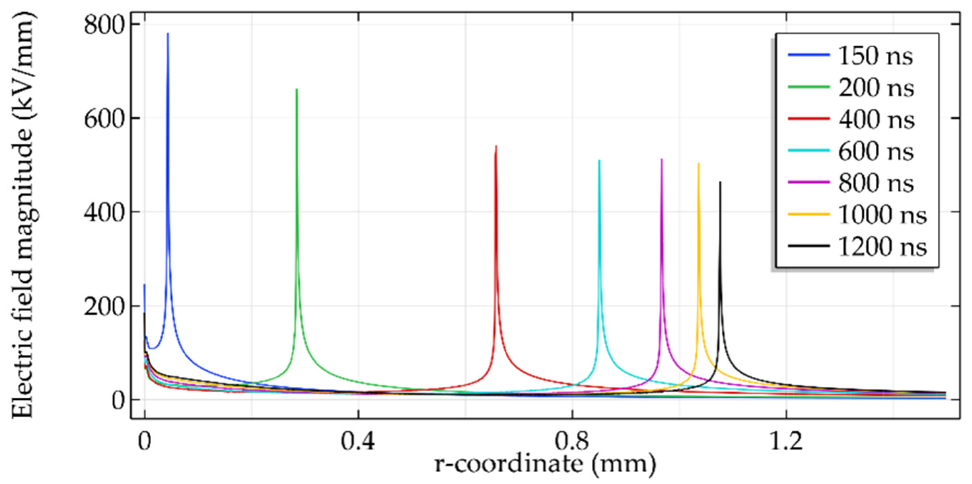
12 of 22 Figure 9. Space charge density (C/m 2 ) along the line ( 𝑂 ) at several instants in the 1st case. Figures 10 and 11 show the electric field magnitude and the space charge density, respectively, at several instants along the line ( 𝐼 ) in the first case. Around 𝑡 = 147 ns , the streamer reaches the oil–OIP interface. At this moment, the electric field and the space charge density are at their maximum values. During the streamer propagation along the